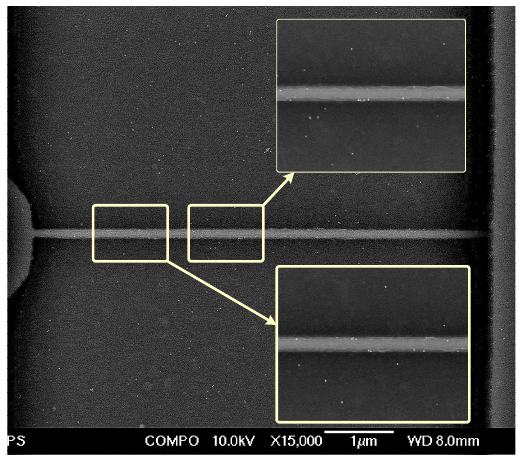
Figure 8. The SEM image of SiNW after the gold nanoparticle-tagging treatment to verify the immobilization of CMP-NANA and